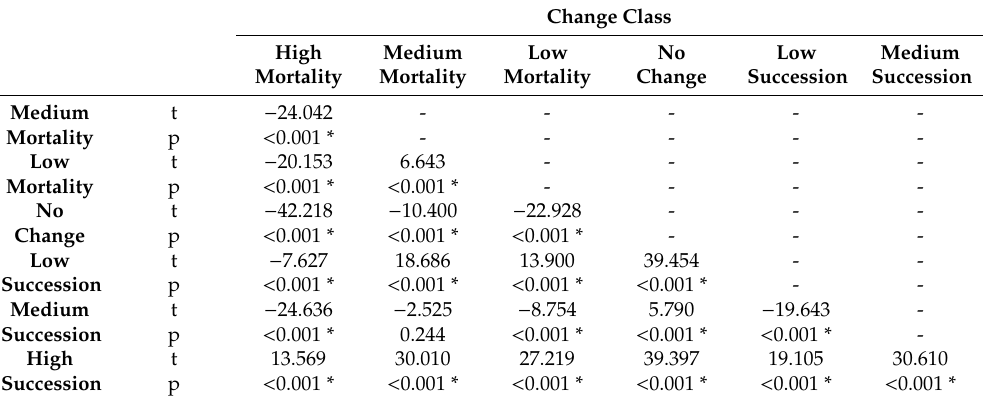
Table 3. Results of elevation t-test between change classes. Significant values in bold. Significant di ff erences were seen in 20 out of 21 tests.